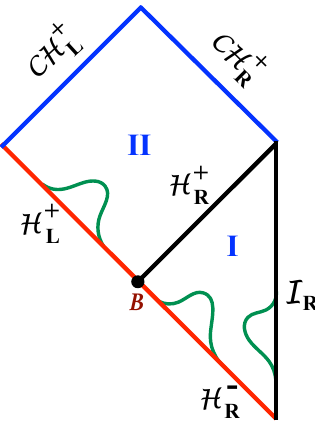
Figure 3 . Our (characteristic) initial-boundary data for solving the Klein-Gordon equation consists of smooth (outgoing) wavepackets on H + determine the solution in regions I and II and investigate its smoothness at CH +